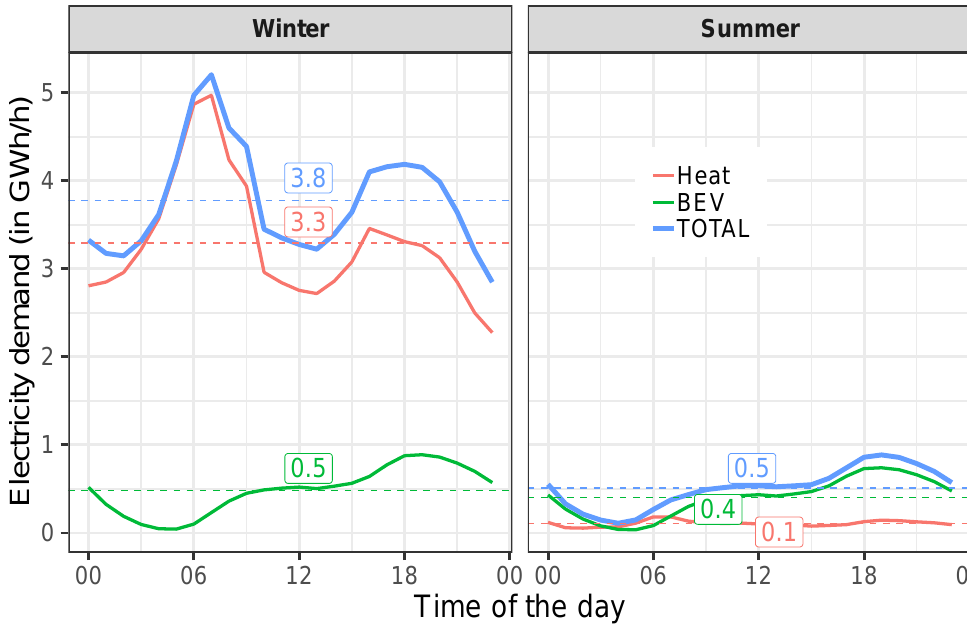
Figure 15. Profile of the hourly electricity demand for heat (SH and DHW), BEV and their sum in a randomly selected day in winter (1 February 2010) and summer (1 July